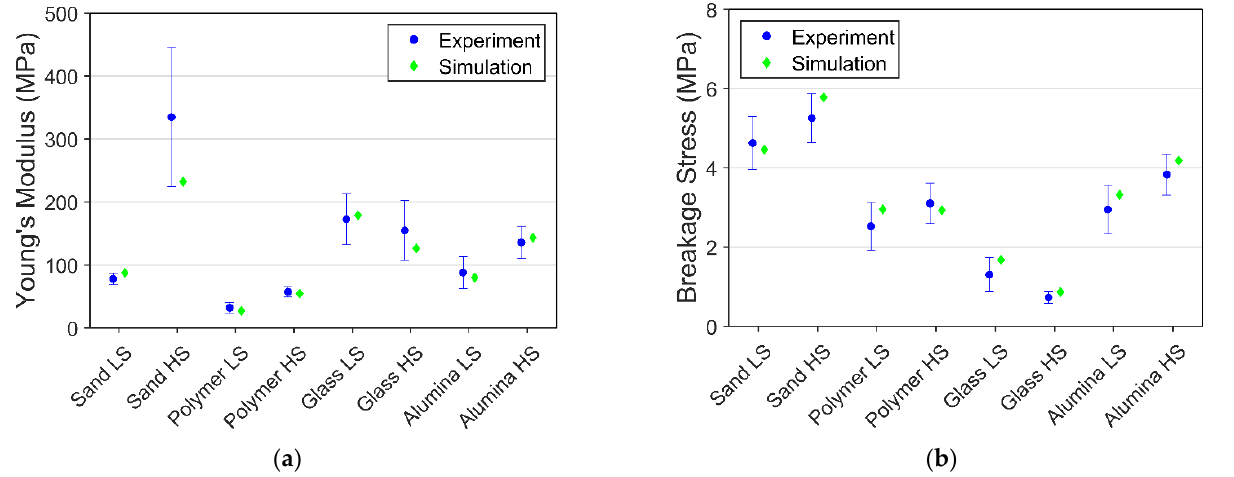
Figure 11. Comparison of experimental and simulation results for 100% saturation at −1 0 °C: ( a ) Young’s modulus; ( b ) Breakage stress. ( a ) Young’s modulus; ( b ) Breakage